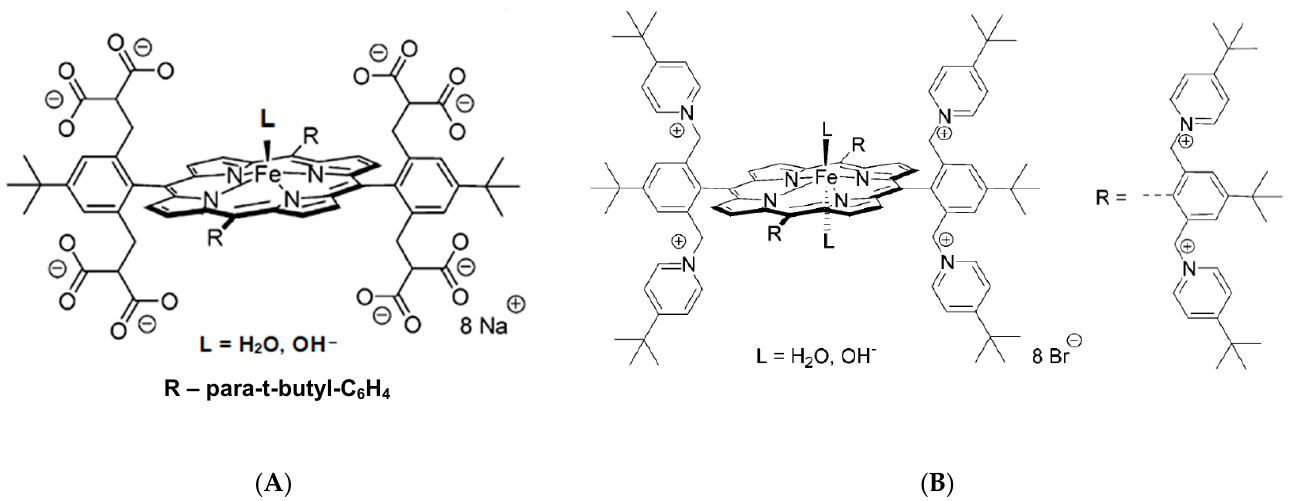
Figure 11. Structure of ( A ) (Por 8+ )Fe III and ( B ) (Por 8 − )Fe III . Reprinted with permission from Inorganic Chemistry , 2005, 44 , 7717–7731 Copyright 2005 American Chemical Society and Inorganic Chemistry , 2006, 45 , 1326–1337. Copyright 2006 American Chemical Society [28,29].